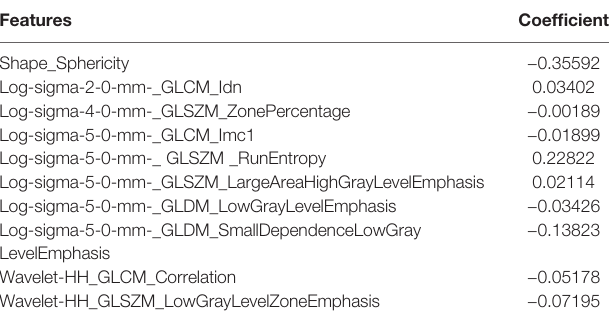
TABLE 2 | Features in the radiomics